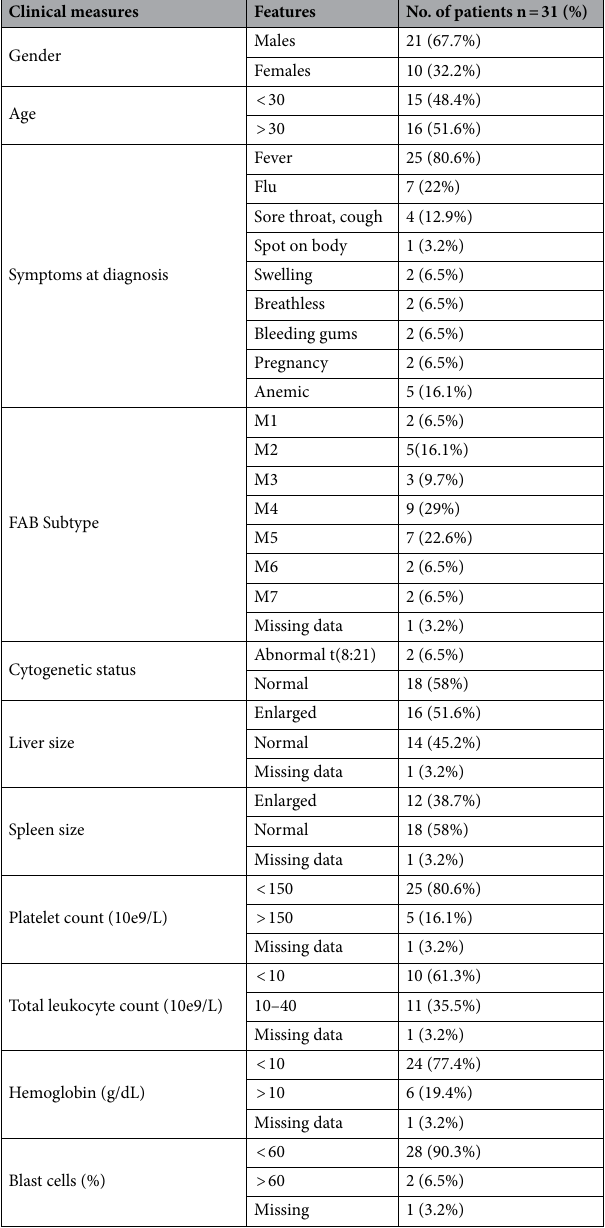
Table 1. Clinical features of AML patients (n = 31) included in the present